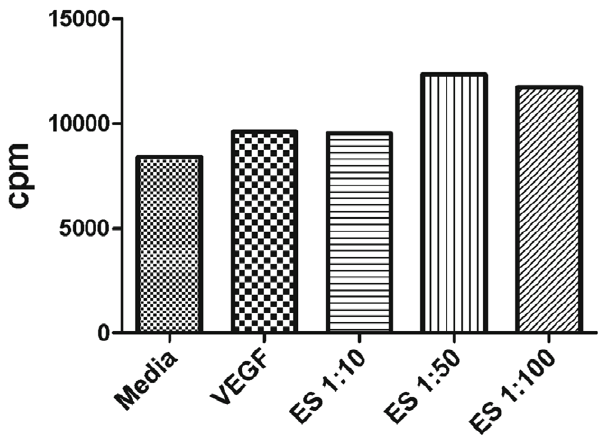
Figure 1. Proliferation of LECs in response to filarial ES products. 5 6 10 4 LECs were plated in a 96 well plate in EBM-2MV and allowed to adhere for 24 hours. Cells were starved for 24 hours in MCBD media and then stimulated with or without VEGF (10 ng/mL) or a dilution series of filarial ES products from 1:10 to 1:100 in MCDB media containing 5% NHS for 72 hours. Thymidine incorporation was measured. Data seen here is one representative LEC proliferation experiment. Various cell lines, cell numbers, starvation conditions, media types and serum types were utilized for optimization of this assay but we never detected reproducible proliferation rates in response to ES products.